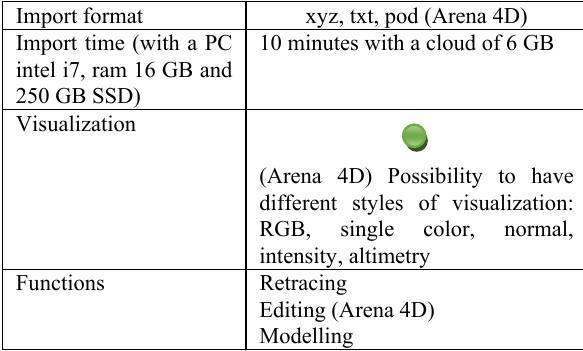
Figure 5. Localization and the composition of the element “Falconatura” on the rooftop plan of Milan’s Cathedral.